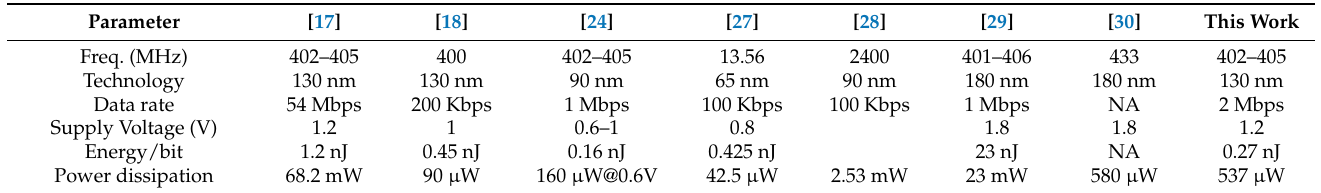
Figure 17. Complete transmitter performance for input data rate 1 Mbps with quench frequency signal 1 MHz. Table 3. Transmitter performance summary and comparison with other OOK super regenerative